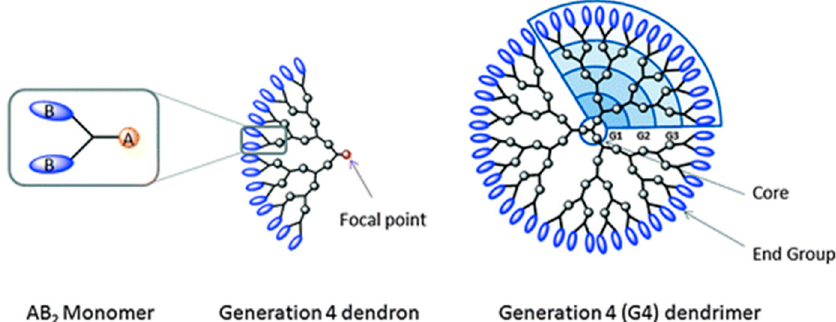
Figure 9. Schematic drawing of an AB 2 monomer and its subsequent use for the synthesis of a generation four dendron and a generation four dendrimer with a tri-functional core. Reprinted with permission from [76]. Copyright 2012, RSC.